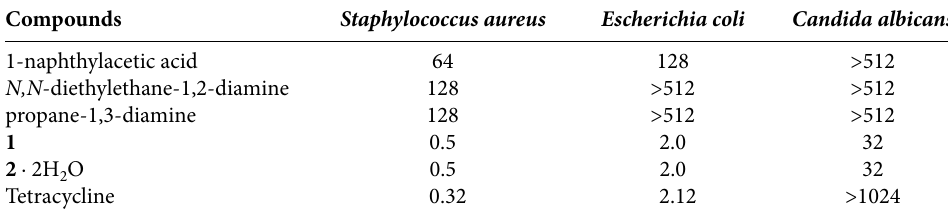
Table 4. MIC values ( μ g mL –1 ) for the antimicrobial activities